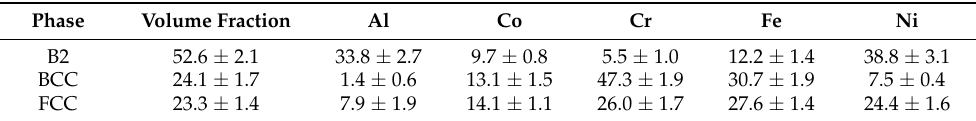
Figure 5. SEM-BSE images of the X 0.5 as-cast alloy: ( a ) low magnification; ( b ) high magnification. Table 4. Chemical composition (at.%) and volume fraction (%) of the interior phases marked in Figure 5.